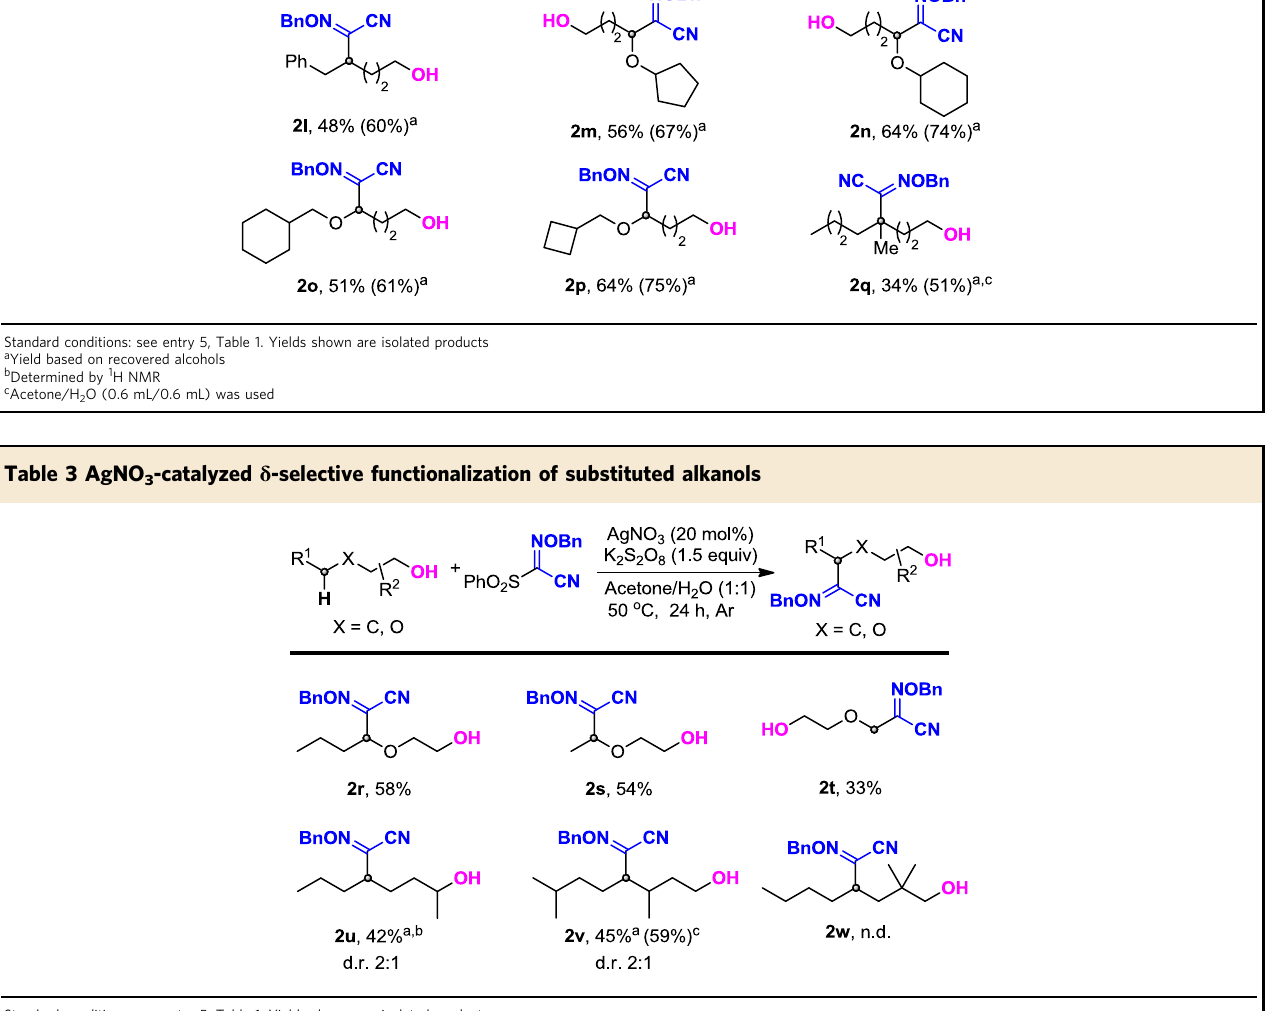
Standard conditions: see entry 5, Table 1. Yields shown are isolated products a Yield based on recovered alcohols b